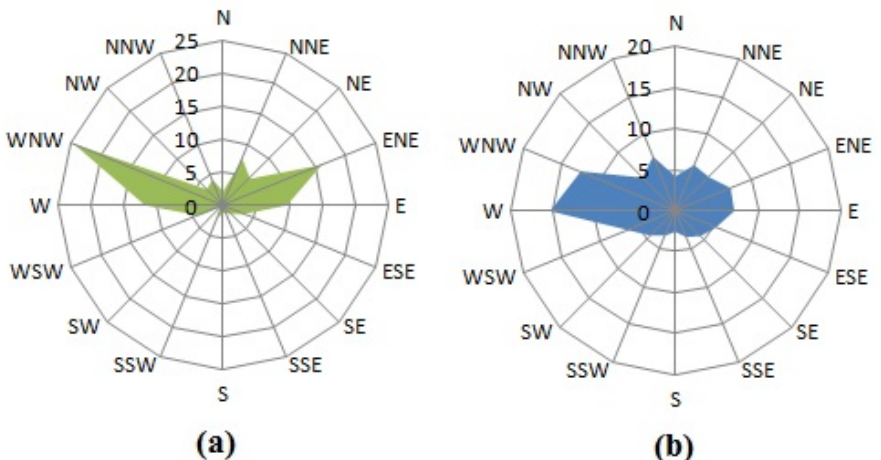
Fig. 4: Annual wind speed distribution direction in %; (a) Girne and (b) Lefkoşa